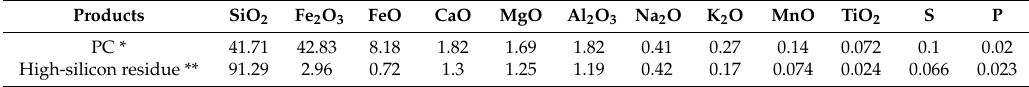
Table 6. Chemical composition of the pre-concentration products / wt